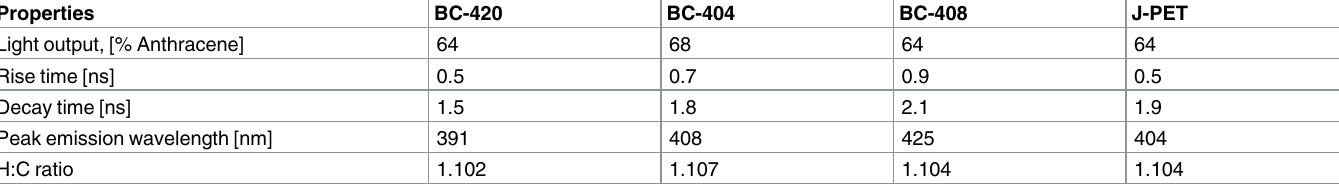
Table 2. Properties of J-PET scintillator and of exemplary plastic scintillators manufactured by Saint Gobain [22].